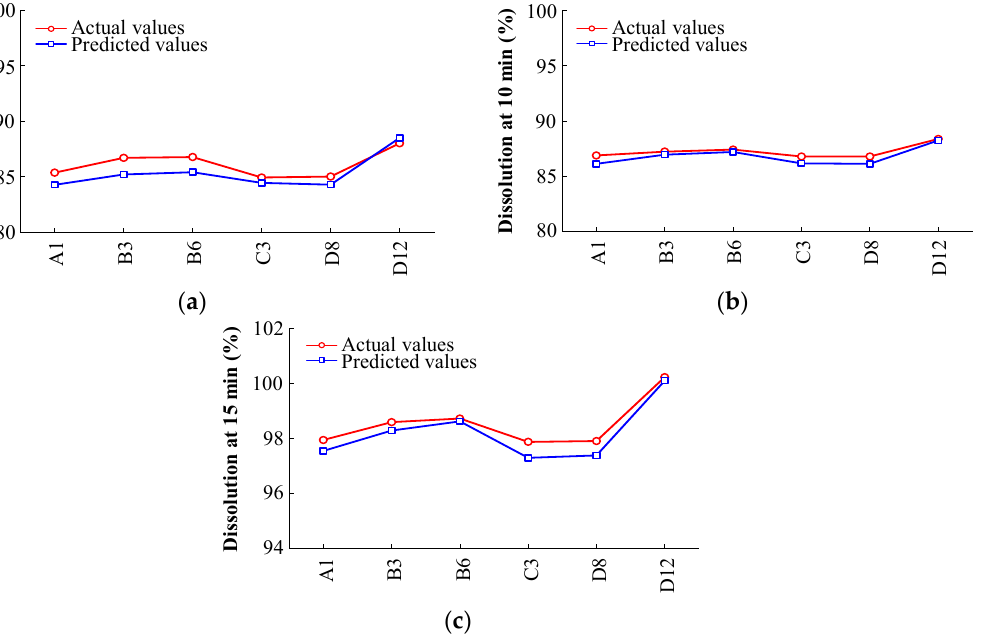
Figure 9. Prediction model verification and fitting curve; ( a ) Actual vs. Predicted dissolution at 5 min; ( b ) Actual vs. Predicted dissolution at 10 min; ( c ) Actual vs. Predicted dissolution at 15 min.